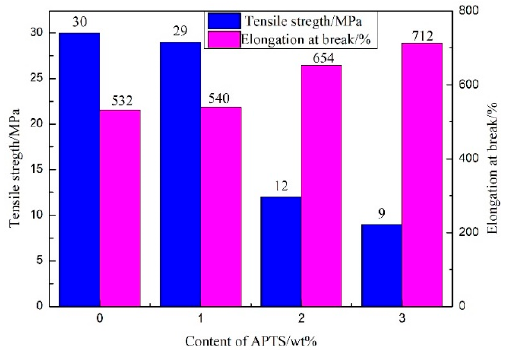
Figure 7. Effect of APTS on the mechanical properties of WPU films. Figure 7. E ff ect of APTS on the mechanical properties of WPU